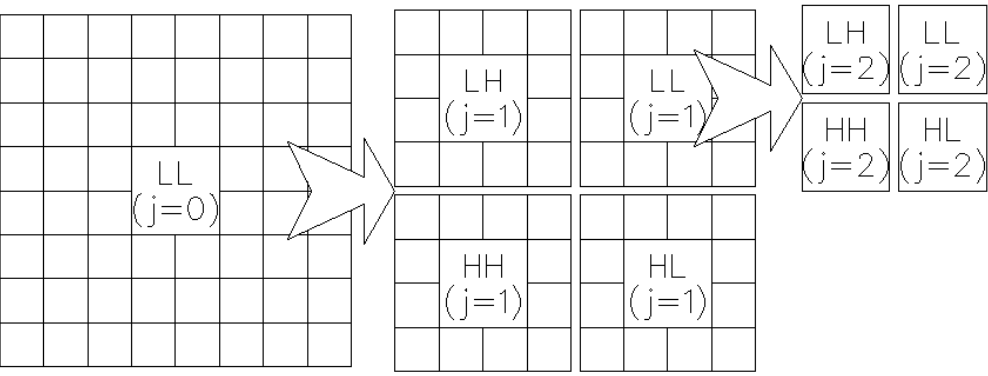
Figure 5. Visual representation of the algorithm of the two-dimension discrete wavelet transform (DWT-2D), where a filtering operation is carried out with a low-pass filter and a band-pass filter in each row. Both filters are applied again on the two resulting matrices, this time in the columns. The result is four subimages, whose size is a quarter of the original image; one of these images is known as the approximation image (double filter LL ), and the remaining three are known as detail images: horizontal ( LH ), vertical ( HL ) or diagonal ( HH